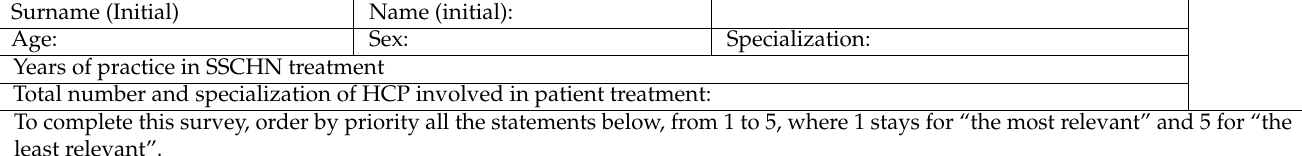
Table 1. The questionnaire proposed to clinicians involved in the treatment of patients with metastatic head and neck